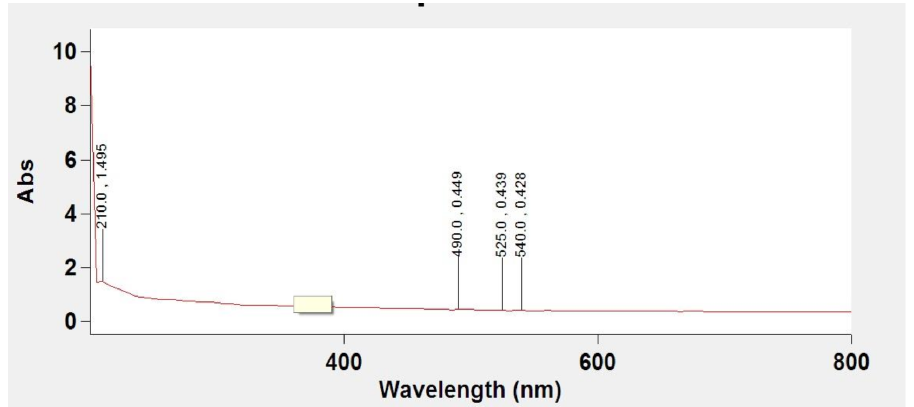
Figure 3. The absorption spectra of prepared MoO 3 -NPs